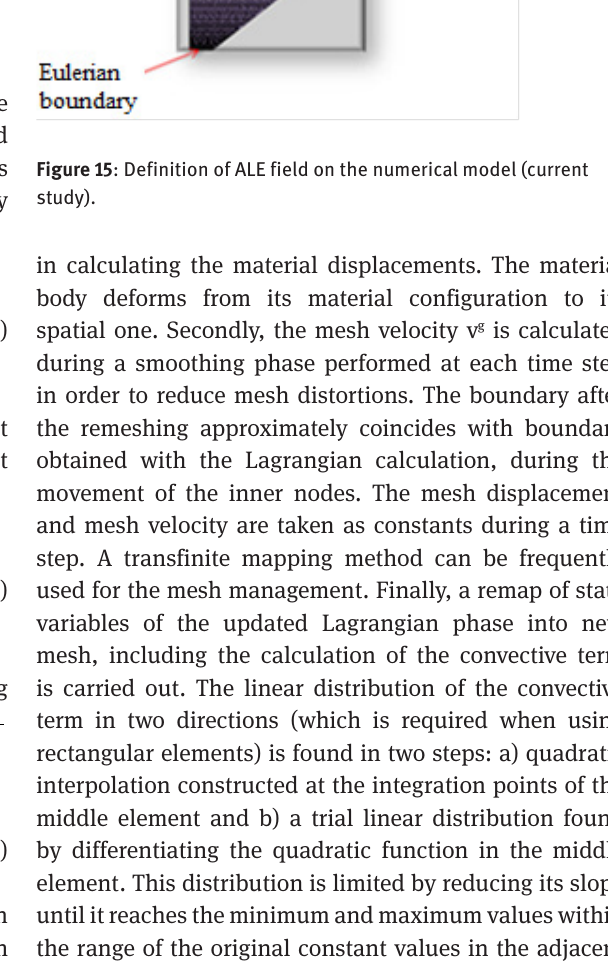
Figure 14 : Adaptive grid Lagrangian–Eulerian – ALE (Abaqus V6.12-1).